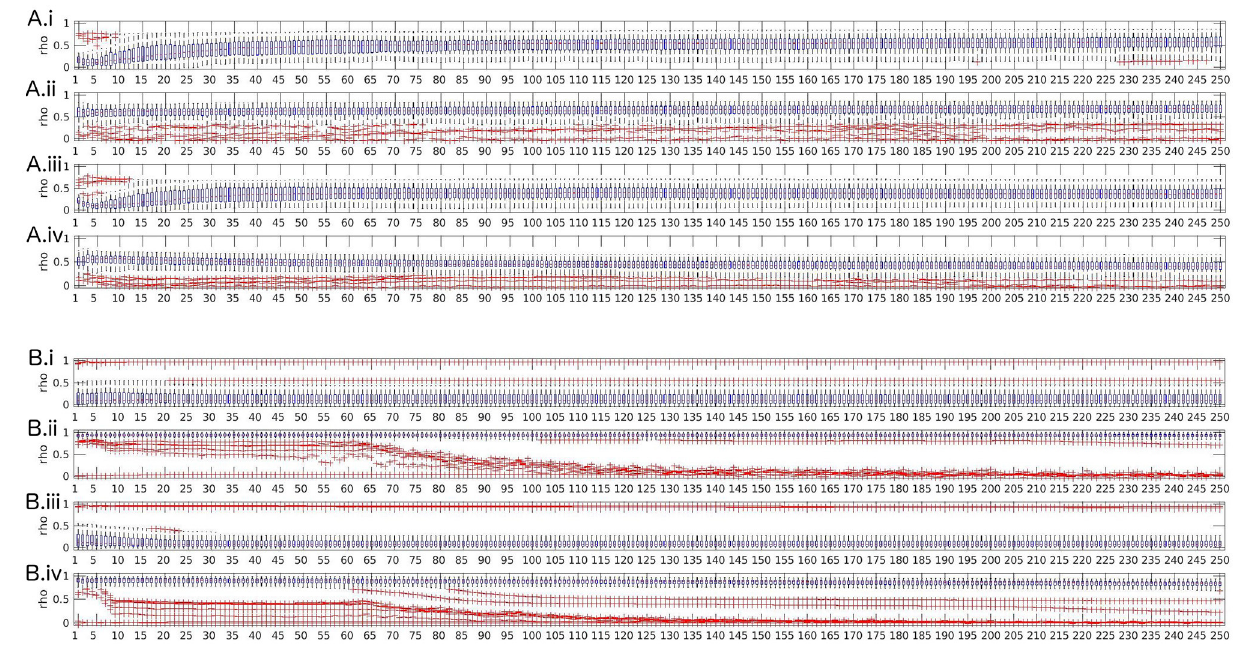
FIGURE 4 | Boxplots of test-retest reliabilities vs. model order for for directed transfer function (A) and real valued coherence (B) . (i) top row: complete data (with artifacts), with frequency averaging; (ii) second row: artifact-free data, with frequency averaging; (iii) third row: complete data without frequency averaging; (iv) bottom row: artifact-free data, without frequency